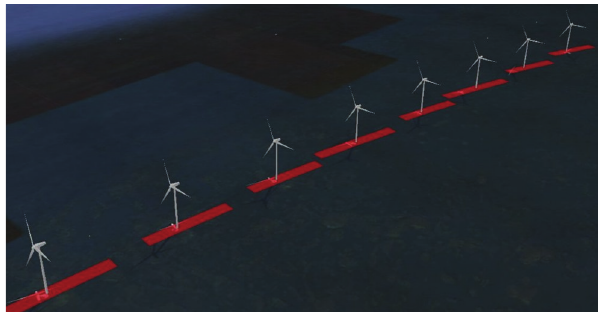
Figure 13: Assessment of the potential impact of Middelgrunden offshore wind farm (Denmark) on fictitious shore-based VTS radar. Red areas over the sea surface represent the clutter that the turbines would generate on the radar display [24,